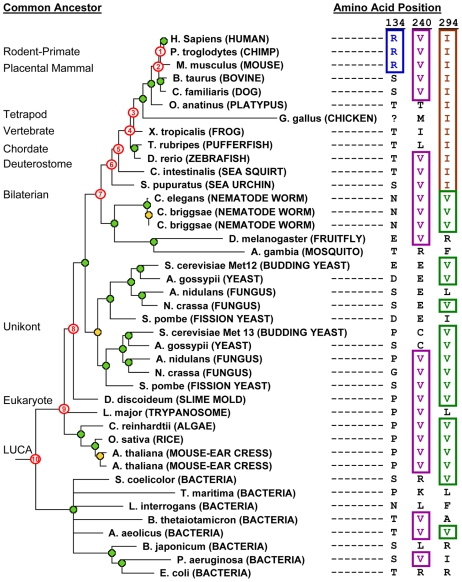
Phylogenetic tree and ancestral allele determination from orthologs of human MTHFR.Tree: MTHFR sequences from modern-day species are indicated. Database identifiers for these entries are listed in Table S2. Gene duplication events are shown with orange circles, and speciation events with green circles. Nodes numbered in red correspond to ancestral branch points in the human MTHFR lineage. Longer branch lengths indicate faster evolutionary rate. The chicken sequence was given an arbitrary, long branch length because it is a sequence fragment and the actual branch length could not be accurately determined. Ancestral allele determinations: The right columns show the amino acids found in the modern-day sequences corresponding to positions 134, 240 and 294 in human MTHFR. These are shown to illustrate how ancestral sites are determined and, consequently, how long the identity of the site in the human enzyme has been preserved in the human lineage (see text for details).